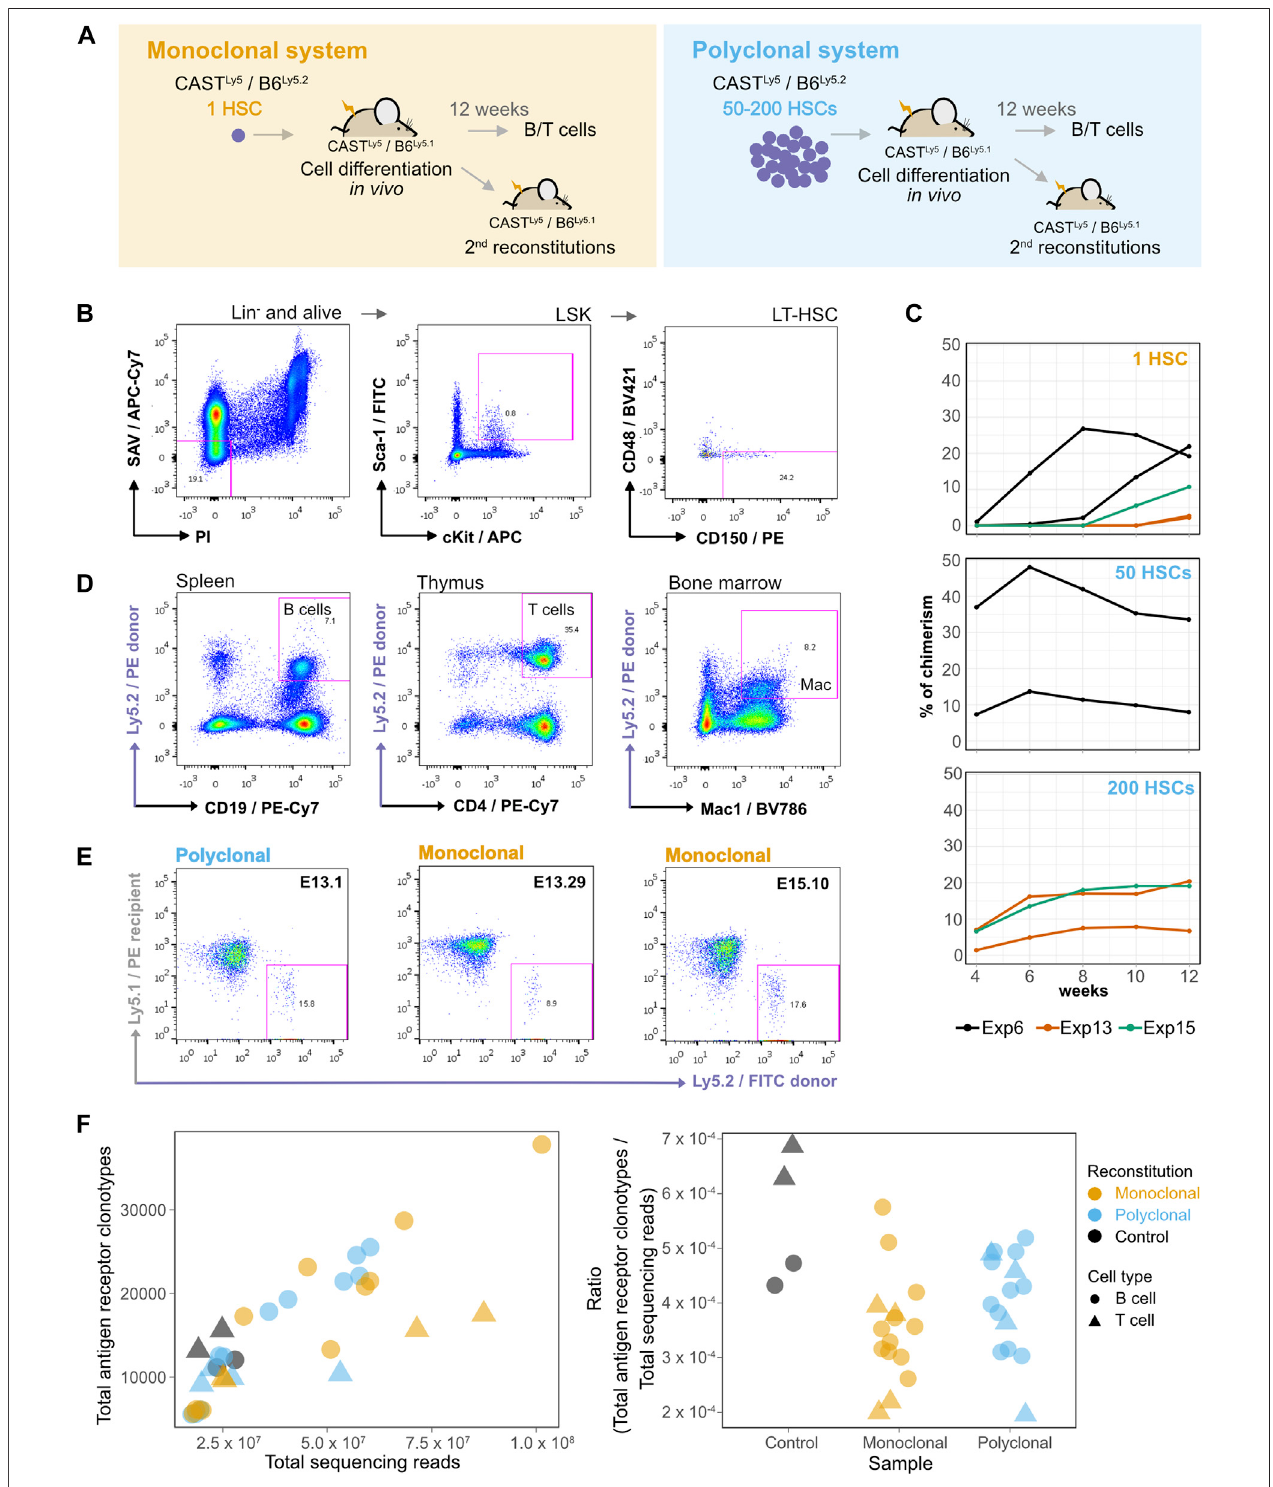
FIGURE 1 | A single hematopoietic stem cell (HSC) gives rise to myeloid and lymphoid cells in the blood with long-term reconstitution. (A) Establishment of monoclonal and polyclonal hematopoietic systems in vivo . A single HSC or 50 – 200 HSCs were injected into sub-lethally irradiated recipient mice to generate a monoclonal or a polyclonal hematopoietic system, respectively. Different donor mice were used in each experiment. Both donor and recipient animals were the F1 progeny of CAST × B6 crosses, but the recipient and donor cells could be distinguished by the presence of a polymorphism in the pan-leukocyte antigen Ly5